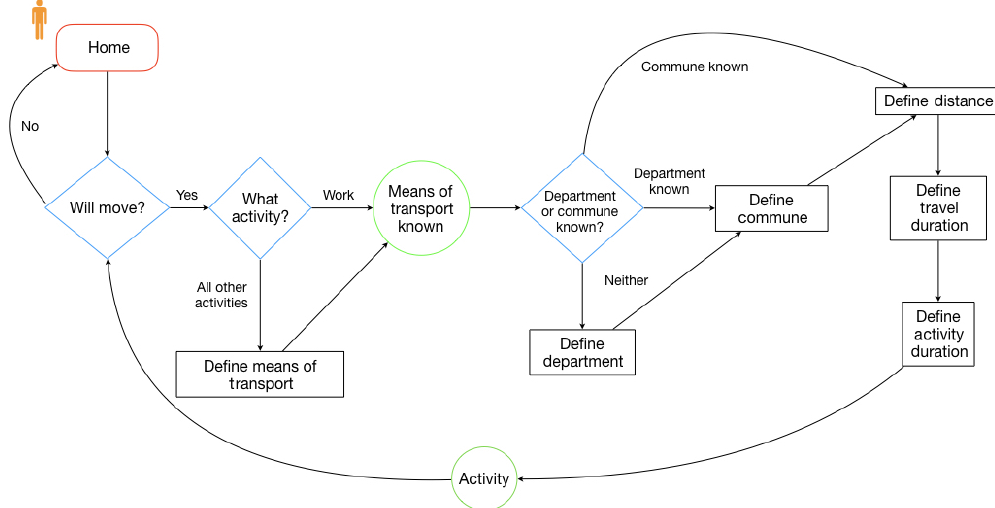
Figure 7. Flow chart of the compilation of activity event sequences.